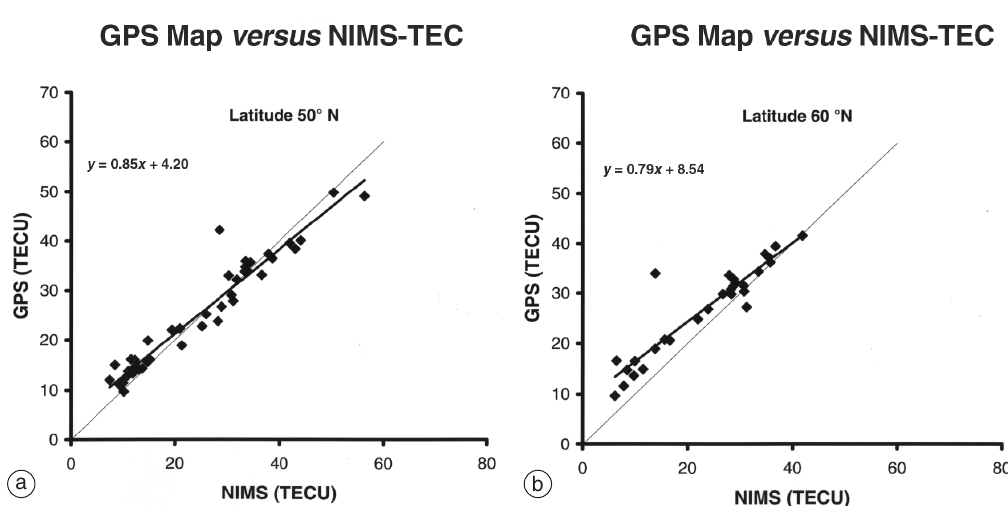
Fig. 8.6a,b. Comparison of equivalent vertical TECs from GPS maps and NIMS observations at latitudes of (a) 50°N and (b) 60°N.